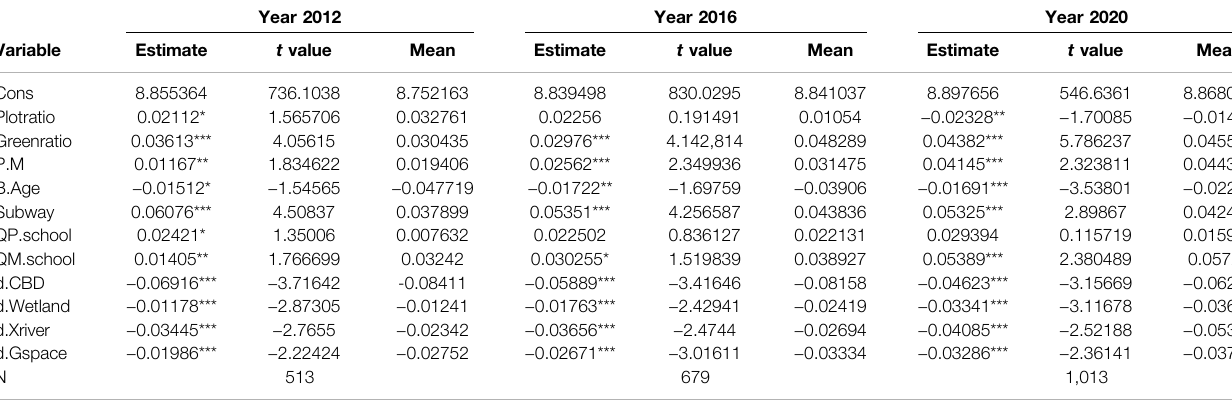
TABLE 4 | 2012, 2016, 2020 Global regression results and GWR mean results.